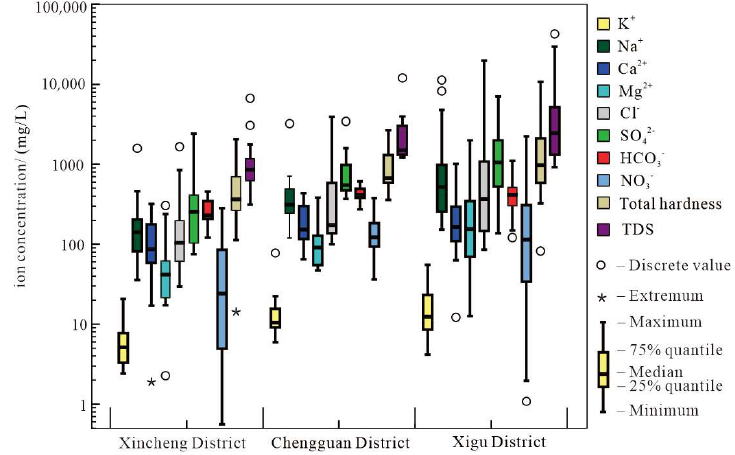
Figure 4. Box plots showing variations in the major indicators of groundwater samples.